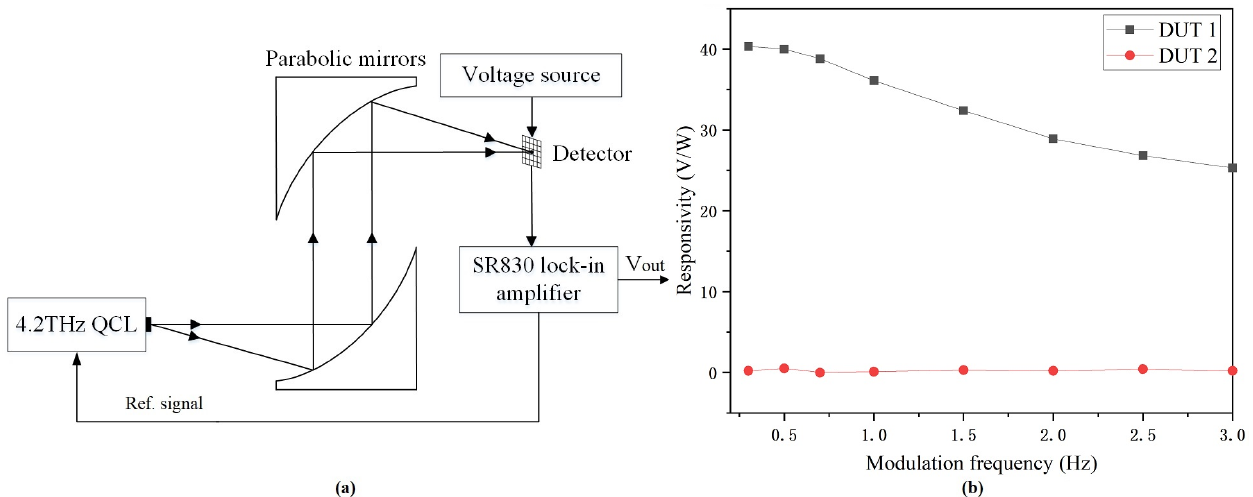
Figure 8. ( a ) Output voltage measurement setup as detectors operate at 4.2 THz. ( b ) Responsiv ‐ ities.